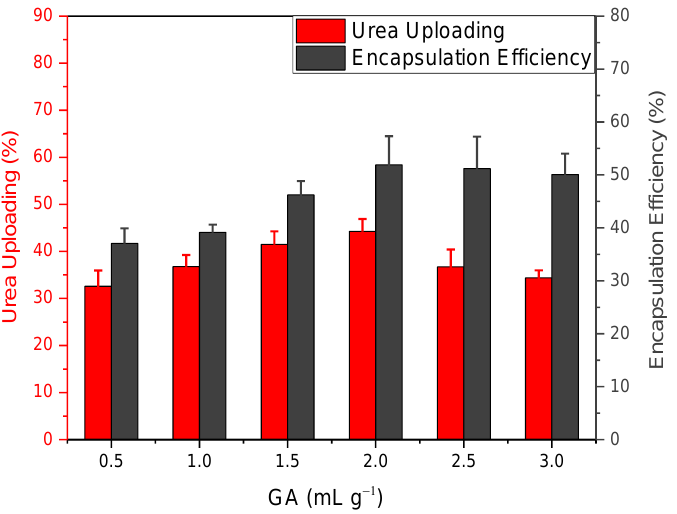
Figure 5. Urea uploading (%) and encapsulation efficiency (%) of A/UG 2:1 film as a function of GA content. All values in the figure are represented as mean ± standard deviation. Table 1. Equilibrium water absorption for several films with differing GA contents.